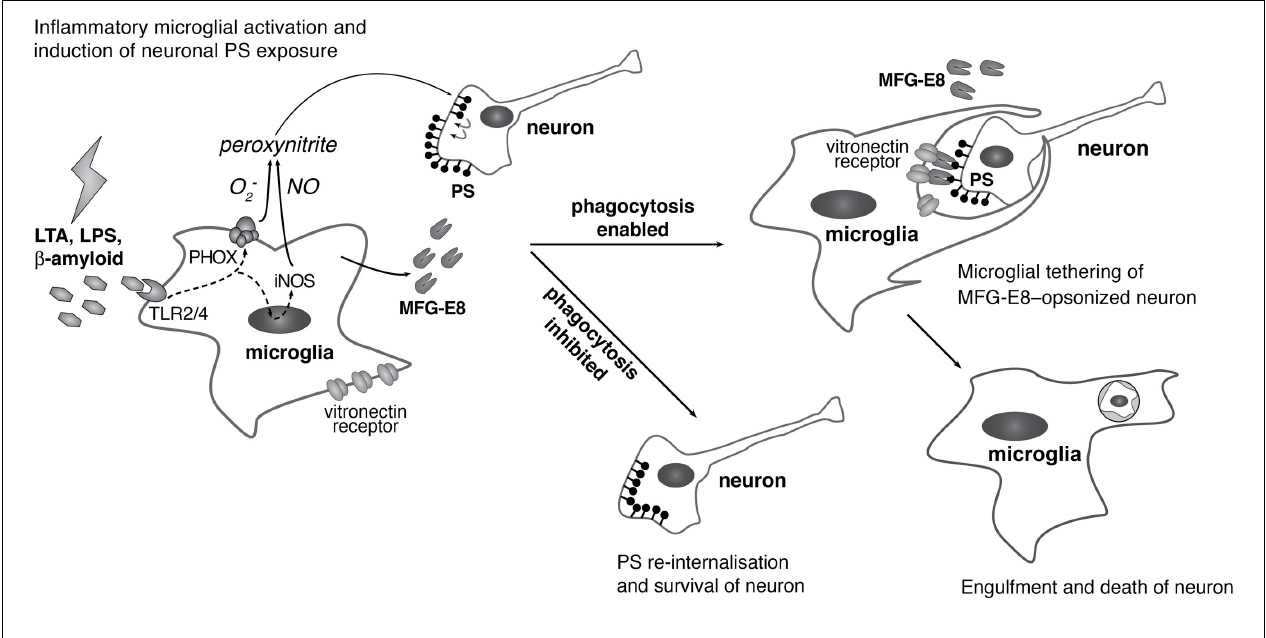
peroxynitrite (while not causing neuronal death) are sufficient to cause FIGURE 1 | Suggested mechanism of primary phagocytosis in neuronal exposure of phosphatidylserine (PS), which is recognized by the inflammatory neurodegeneration. Inflammatory microglial activation with bridging protein MFG-E8 (milk fat globule EGF-like factor 8). MFG-E8 also lipopolysaccharide (LPS), lipoteichoic acid (LTA), or amyloid- β (A β ) through binds to the microglial vitronectin receptor (the heterodimeric α v β 3/5 integrin), Toll-like receptors-2/4 induces expression of inducible nitric oxide synthase (iNOS) and assembly of the phagocytic NADPH oxidase (PHOX). iNOS and thereby causing engulfment of the PS-exposing neuron. If phagocytosis is ) , respectively, which PHOX produce nitric oxide (NO) and superoxide ( O − blocked, however, neurons are able to re-internalize PS, thus evading 2 phagocytosis and react to form low concentrations of peroxynitrite.These sublethal levels of